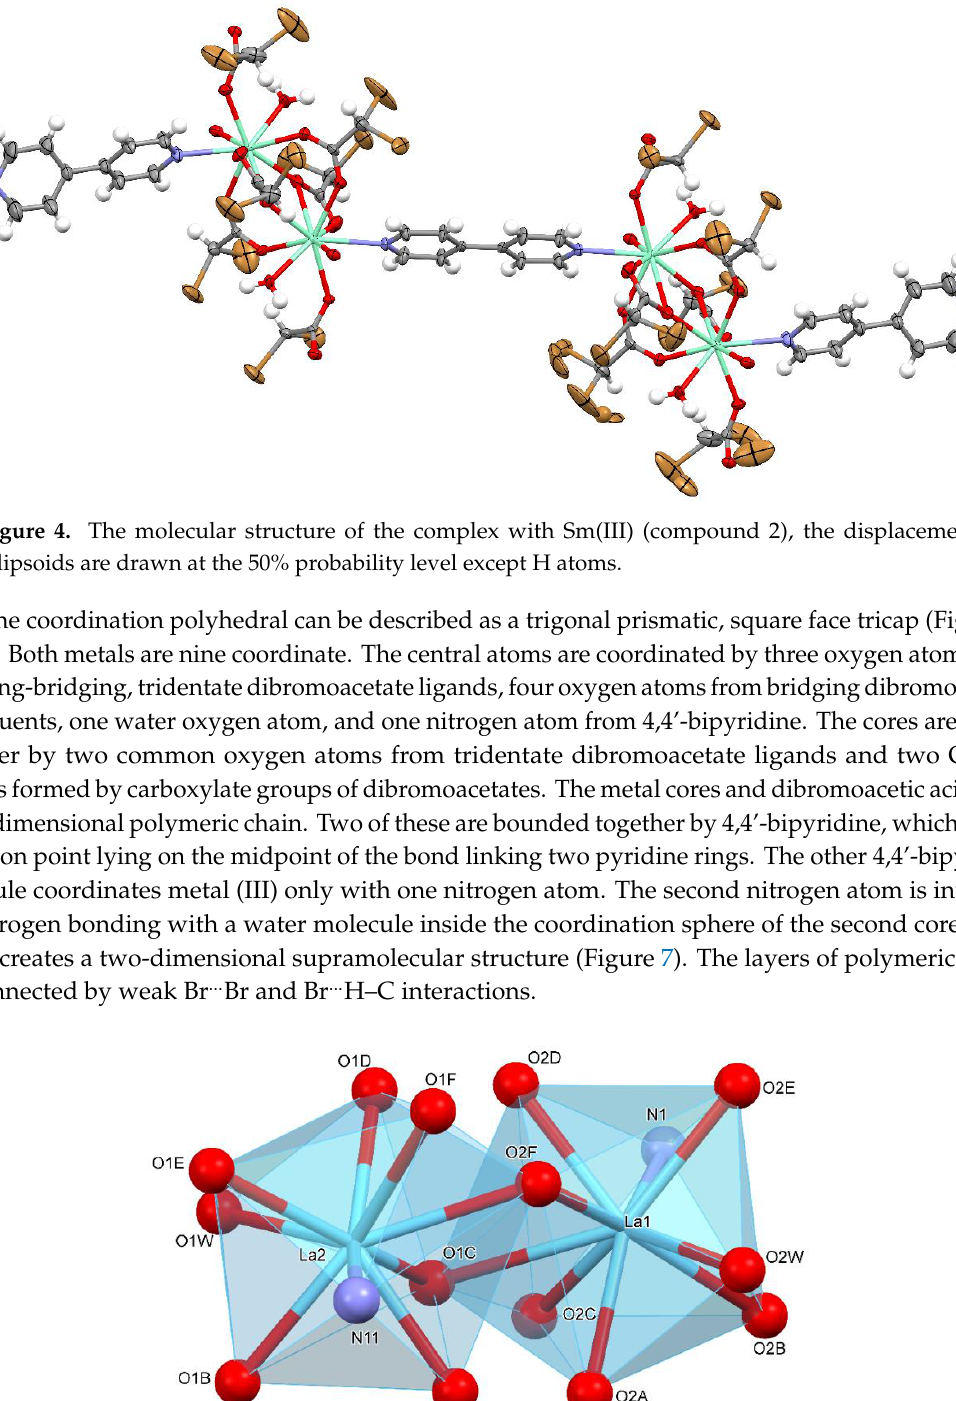
Table 2. Crystal and structure refinement data for study complexes. Figure 3. The molecular structure of complex with La(III) (compound 1), the displacement ellipsoids are drawn at the 50% probability level except H atoms.